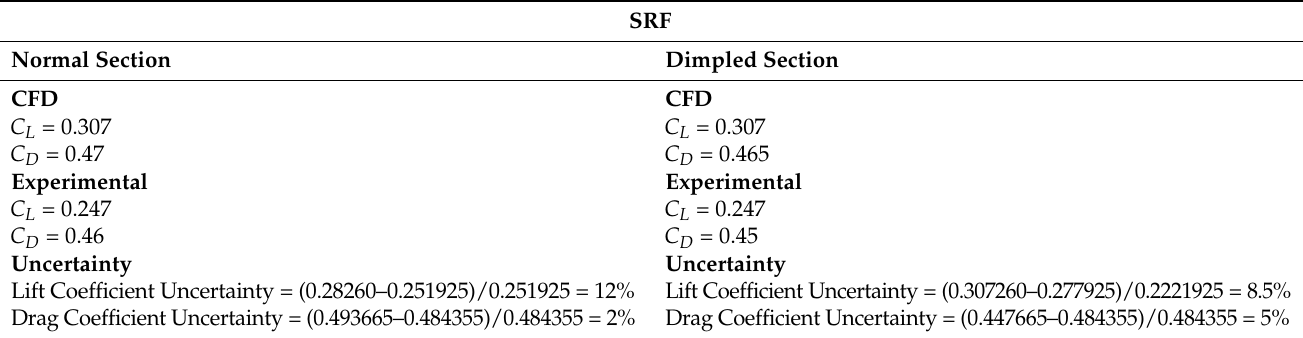
Table 3. Uncertainty calculations of both sections of a turbine blade at an optimum AOA for SRF .